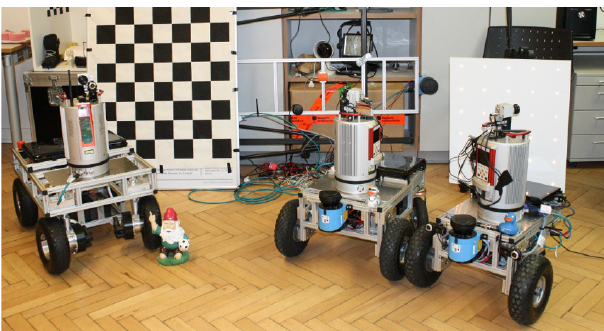
Figure 1. A variety of mobile laser scanners exists. ( a ) Custom built robots on a Volksbot chassis using the Riegl VZ-400 as its main sensor. From left to right, the robots